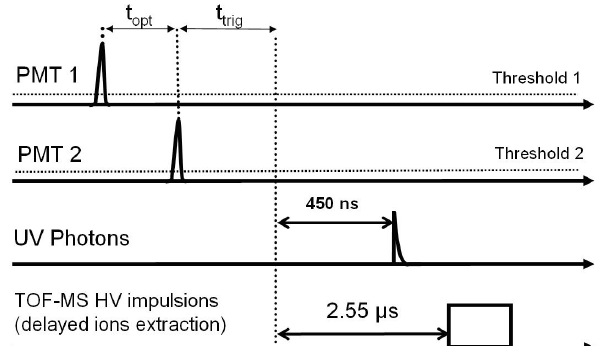
Fig. 6. Chronogram of the synchronization between optical detection and laser